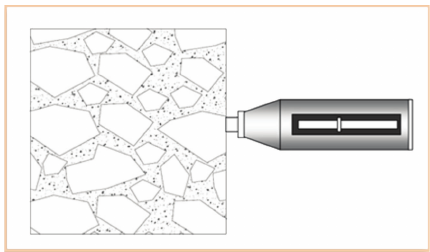
Figure 1: Sclerometer beats against a large piece of aggregate.